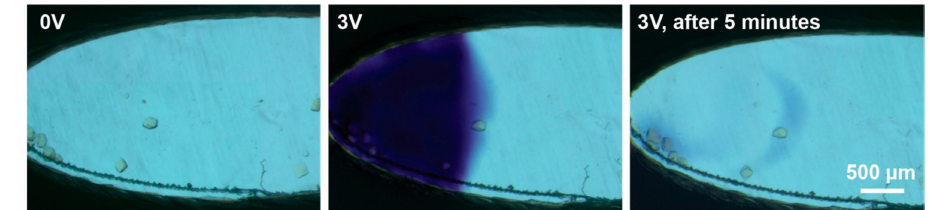
Figure 4. Optical micrographs of an electrocrystallization device containing 150 mM of methyl viologen (MV) and crystals of lysozyme under the influence of 0 V, 3 V, and 3 V at longer times. The initial color change from clear to purple is the result of the reduction of MV 2+ to MV + , while the subsequent loss of color at higher voltages and longer times is due to the further reduction from MV + to MV 0 . The pale yellow color of the MV 0 was difficult to discern compared to the fully oxidized MV 2+ species, because of the small path length in our microfluidic devices. Color changes were only observed in the vicinity of the